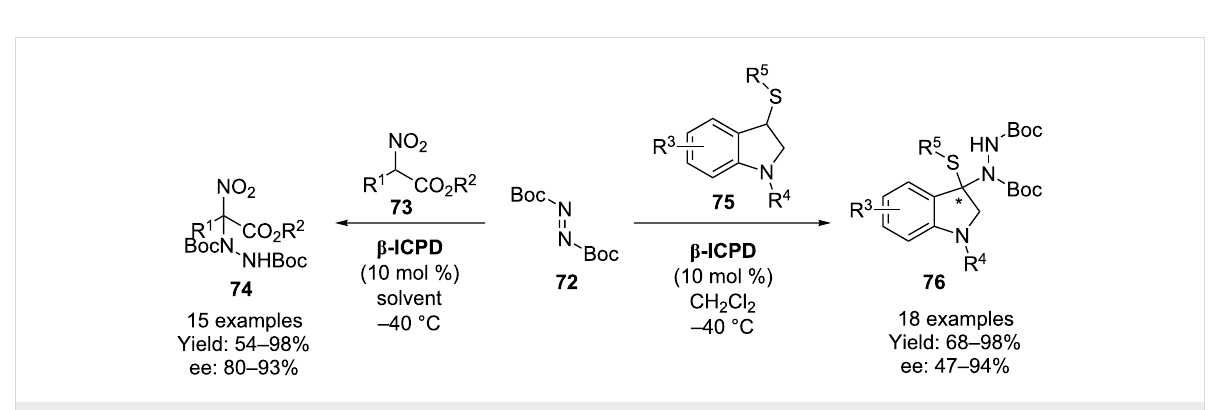
Scheme 18: Zhou’s α -amination using β -ICPD